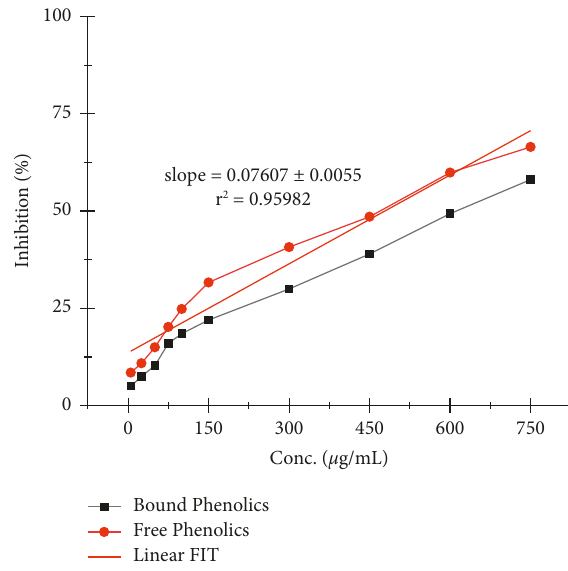
Figure 5: α -Glucosidase median inhibitory potential of Veronica biloba phenolics.